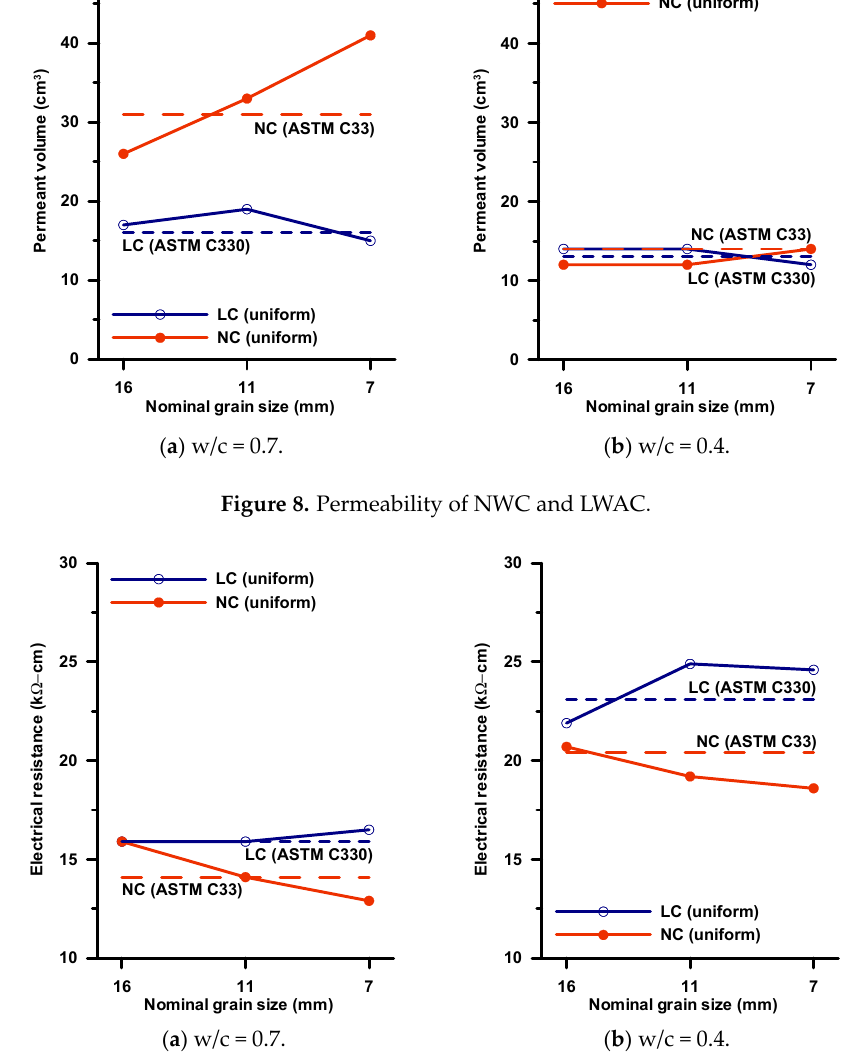
Figure 9. Electrical resistance of NWC and LWAC.